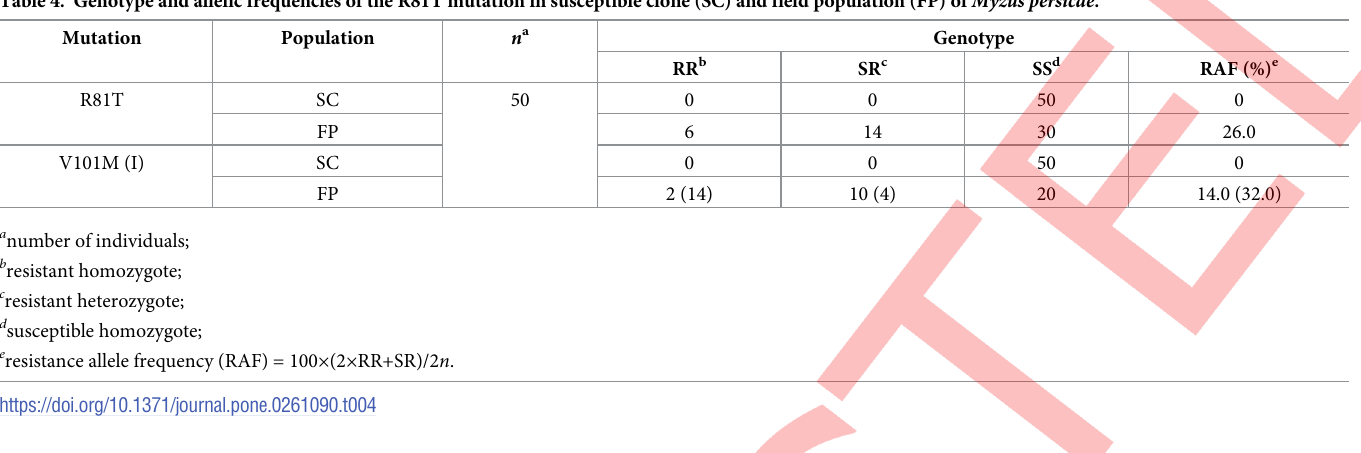
M . persicae (Fig 2). The RAF of V101M was 14%, while V101I displayed 32% frequency in FP. Interestingly, there were no other mutations when R81T mutation was present in homozygous form and there were no other mutations when V101I was present in homozygous form in nAChR. The schematic illustration of both mutations in M . persicae and their protein-coding